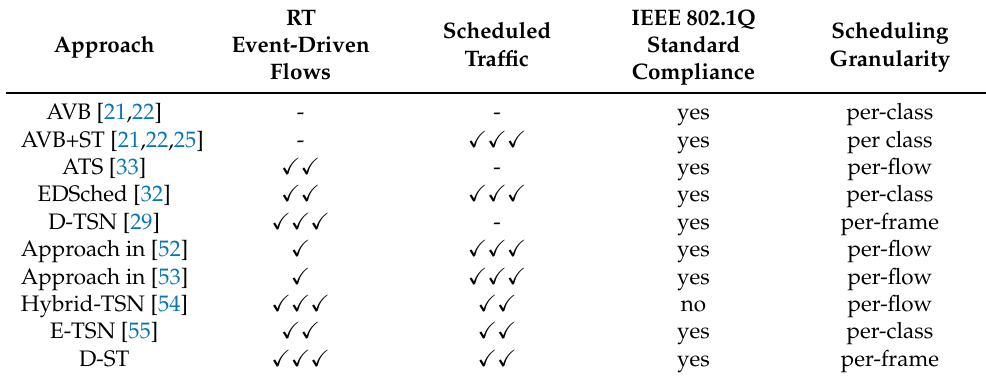
Table 1. Comparison of state-of-the-art transmission